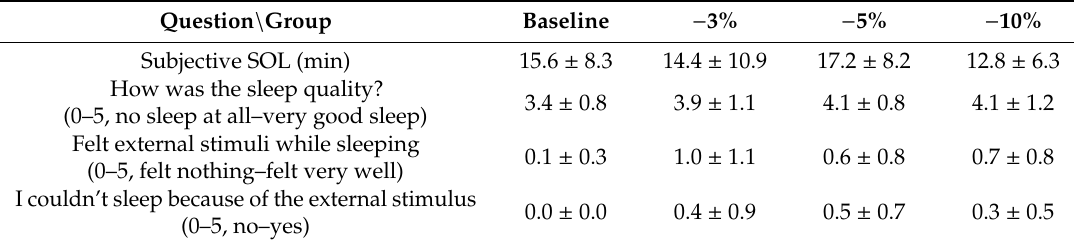
Table 4. Questions about sleep and comfort of the stimulation (mean ± standard deviation). Question \